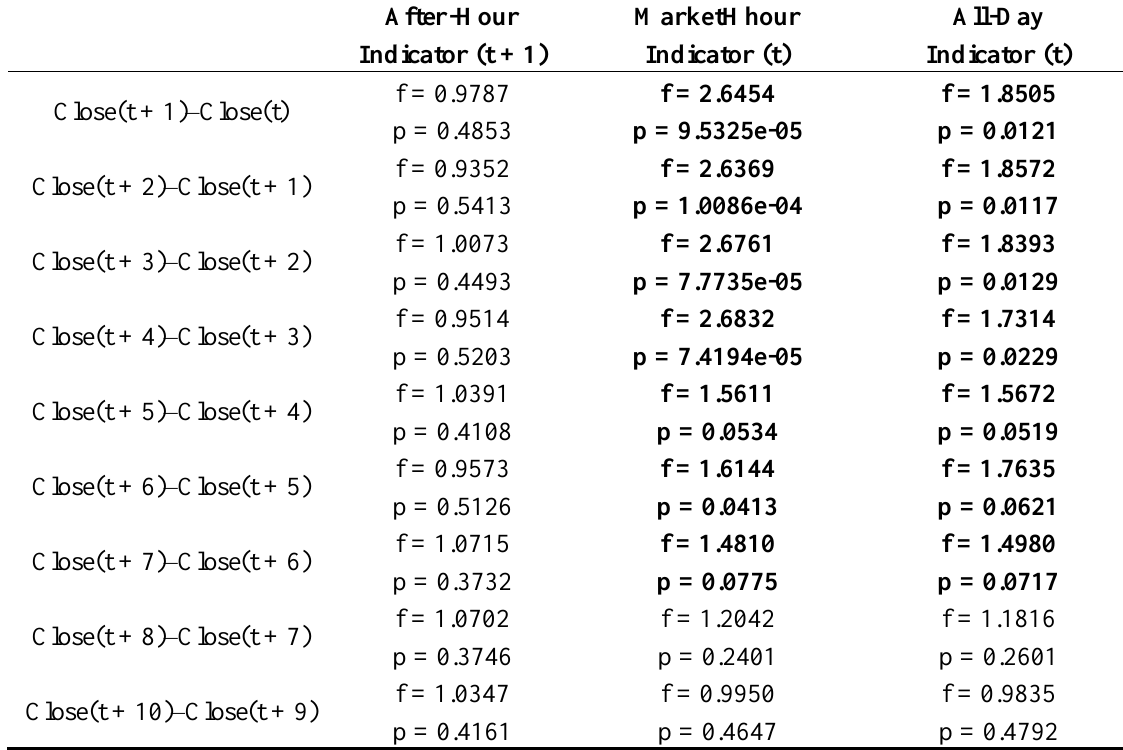
Table 6. Granger causality test on the all-day/market-hour/after-hour indicators at time t and the S&P500 index daily change on day T (T > t). Test statistics that are significant at the 10% level are in bold. After-Hour MarketHhour All-Day Indicator (t + 1) Indicator (t) Indicator